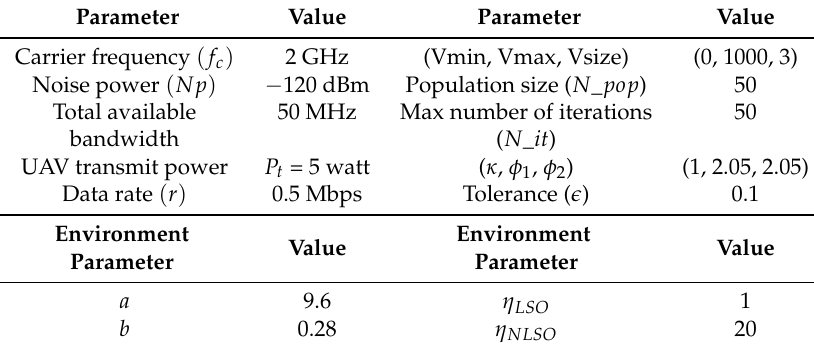
Table 2. Simulation parameters.